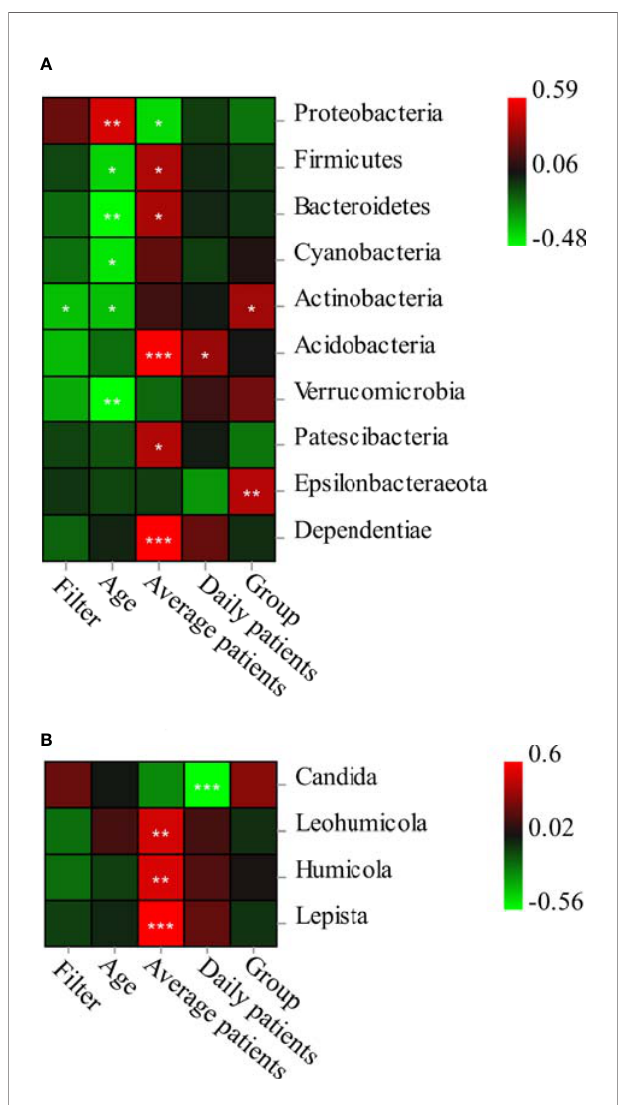
FIGURE 5 | The Pearson correlation analysis of bacterial ( A at phylum level)/ fungi) ( B at genus level) composition and fi ve environmental factors. The interpretations of variables: fi lter-the application time of fi lter unit; age, age of dental unit; average patients, average patients per month; Daily patients- number of patients on the sampling day; Group-specialty of dental treatment. *signi fi cant at p < 0.05, **signi fi cant at p < 0.01, ***signi fi cant at p <